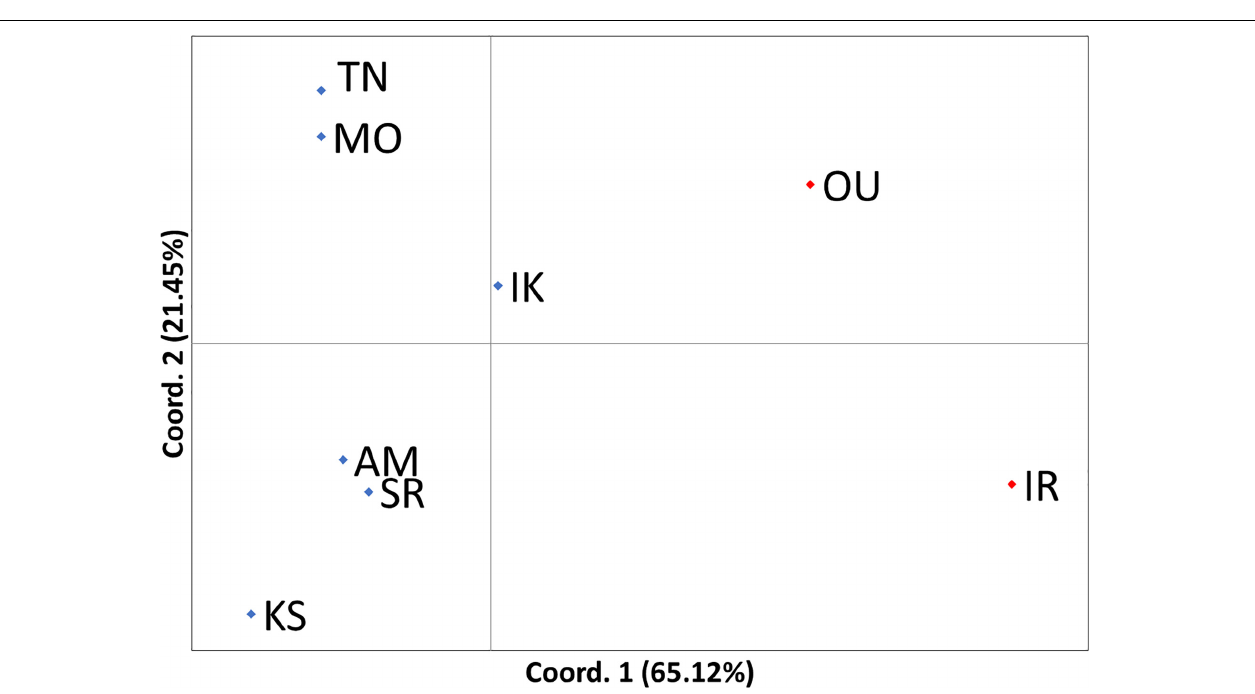
FIGURE 4 | STRUCTURE bar-plot results using no prior (upper) at K = 3, geographic prior at K = 2 (middle), and morphological prior at K = 2 (lower). The x -axis indicates each individual, and the y -axis indicates the proportion of assigned clusters shown in different colors.